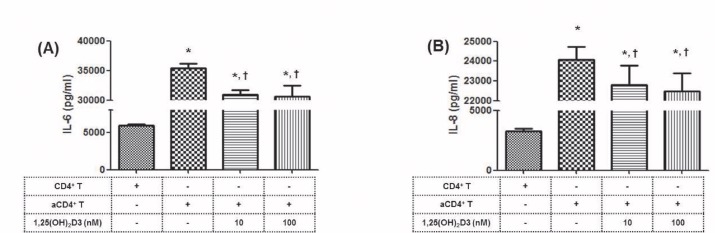
Effect of 1,25(OH)2D3 on the production of inflammatory cytokines by HRPTEpiC, induced by activated CD4+ T cells.(A) IL-6 and (B) IL-8 production by HRPTEpiC which were pre-treated with 1,25(OH)2D3 (10 nM) as indicated, and then co-cultured for 48 hours with activated CD4+T cells. Note that treatment with 1,25(OH)2D3 did suppress the production of IL-6 and IL-8 by HRPTEpiC. *P<0.05 vs. CD4+ T control and †P<0.05 vs. activated CD4+ T. Values are expressed as the mean and SD of triplicate cultures. 1,25(OH)2D3, 1α,25 dihydroxy-vitamin D3; HRPTEpiC, human renal proximal tubular epithelial cells